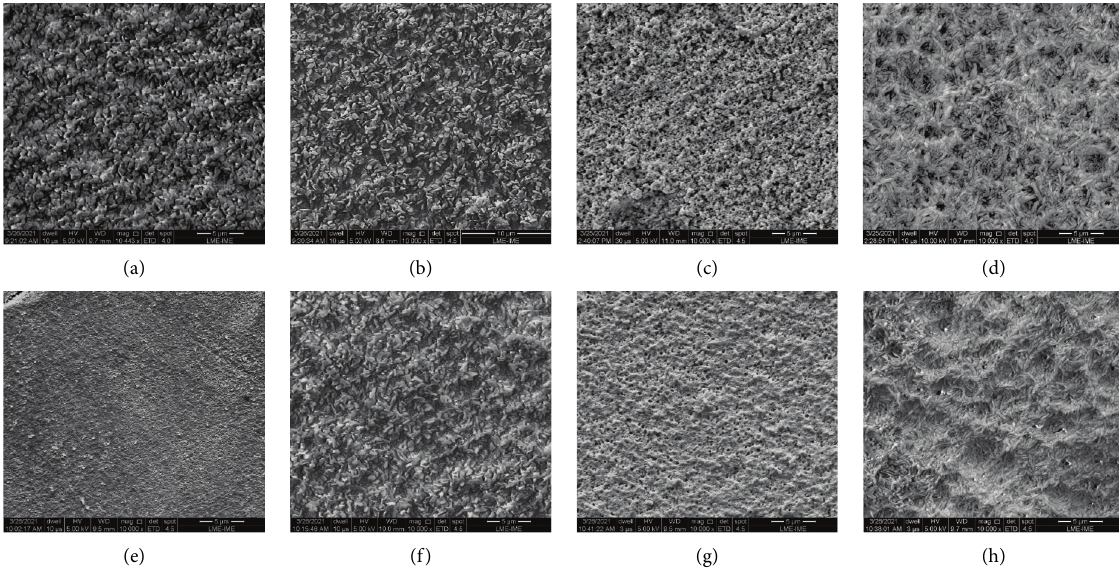
Figure 1: SEM micrographs of samples: (a) G1, Celtra Duo crystallized; (b) G2, Celtra Duo noncrystallized; (c) G3, e.max CAD non- crystallized; (d) G3, e.max CAD crystallized; (e) G4, Vita Suprinity noncrystallized; (f) G4, Vita Suprinity crystallized; (g) G5, Rosetta SM noncrystallized; (h) G5, Rosetta SM crystallized.